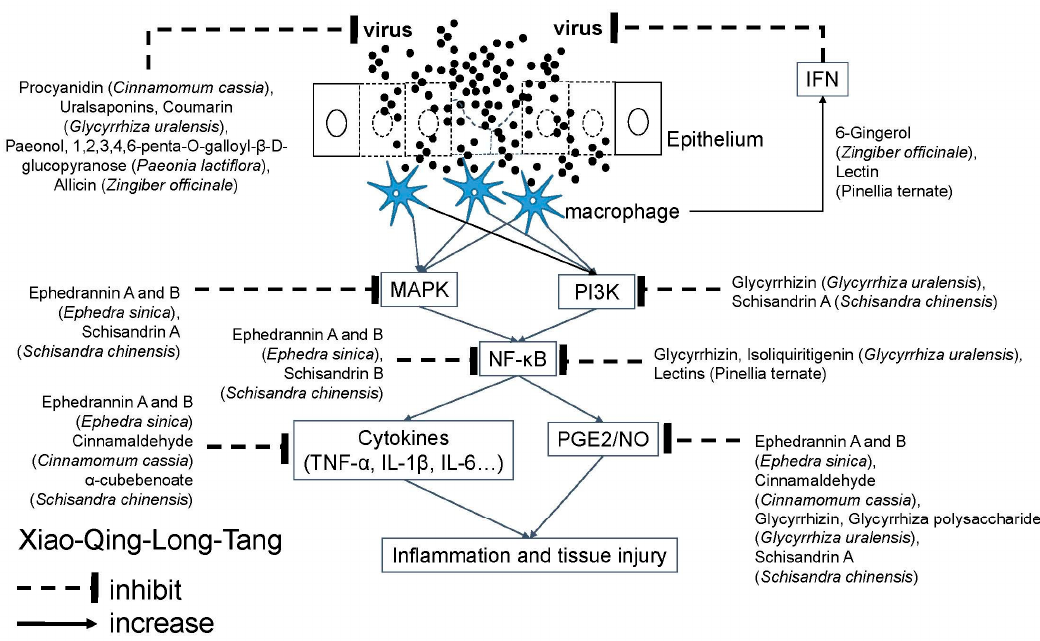
Figure 5. Molecular mechanism of Xiao-Qing-Long-Tang against airway viral infections. Airway viruses infect the epithelium to cause tissue injury. Xiao-Qing-Long-Tang contains several active molecules to inhibit viral replication and signal transduction of inflammatory response. Akt: Serine / threonine protein kinase B (PKB); COX: Cyclooxygenase; ERK: Extracellular signal-regulated kinase; IL: Interleukin; iNOS: Inducible nitric oxide synthases; JNK: c-Jun N-terminal kinases; MAPK: Mitogen-activated protein kinase; NF- κ B: Nuclear factor-kappa B; NO: Nitric oxide; PG: Prostaglandin; PI3K: Phosphoinositide 3-kinase; PMN: Polymorphonuclear neutrophils; TNF: Tumor necrotic factor.